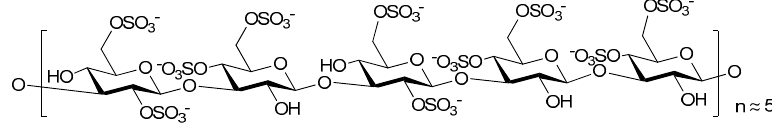
Figure 10. Structure of PS3; the sodium salt of a β -1,3-glucan sulfate with a degree of sulfation of 2.2 and a polydispersity of 25 corresponding to a mean molecular weight of 10,000.